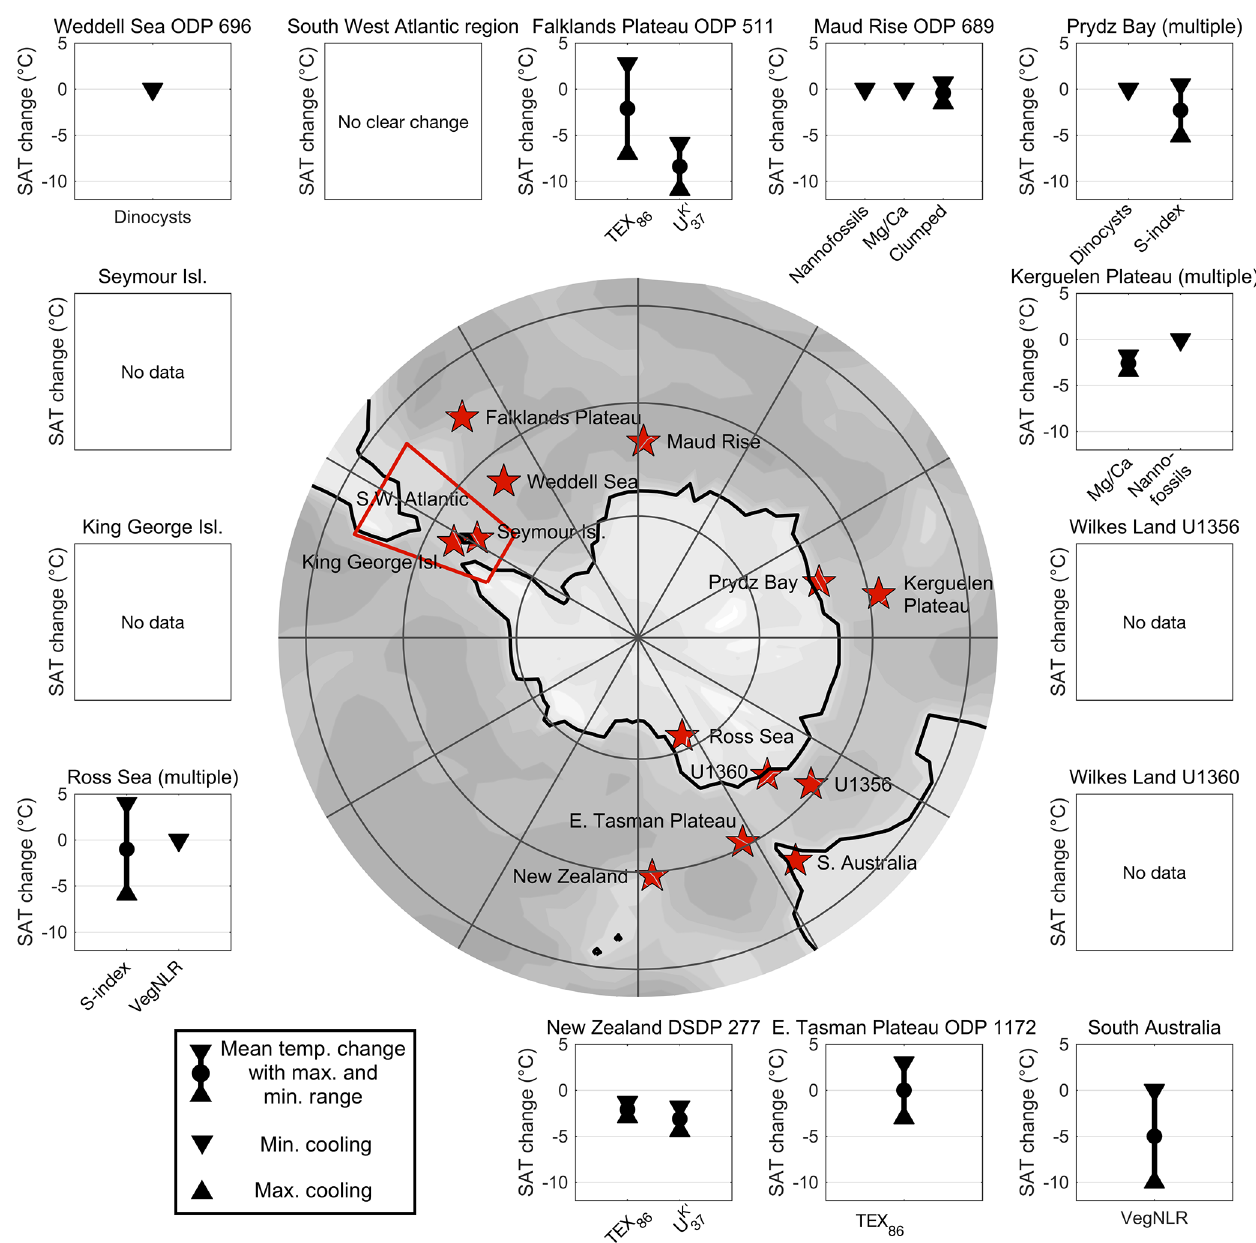
Figure 2. Changes in mean annual temperature ( ◦ C) from proxy records for all sites across the EOT. The mean values (circles) are shown with maximum and minimum values (error bars), while ordinal limits are shown by upward- or downward-pointing